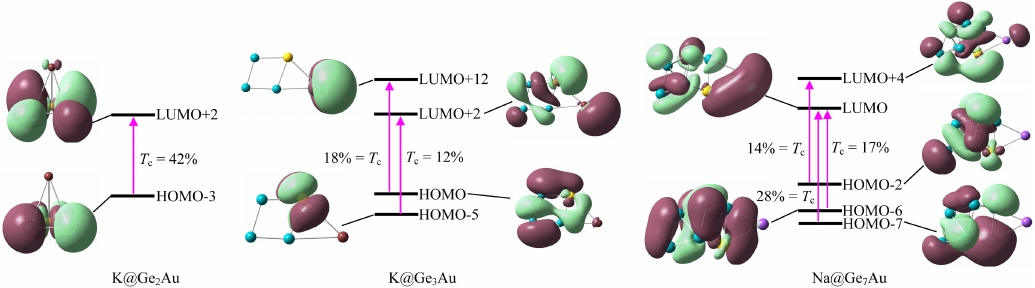
Figure 7. Frontier molecular orbitals involving in the crucial transitions ( T c ) for the K@Ge 2 Au, K@Ge 3 Au, and Na@Ge 7 Au clusters, computed at the CAM-B3LYP/def2-TZVPD level of theory.